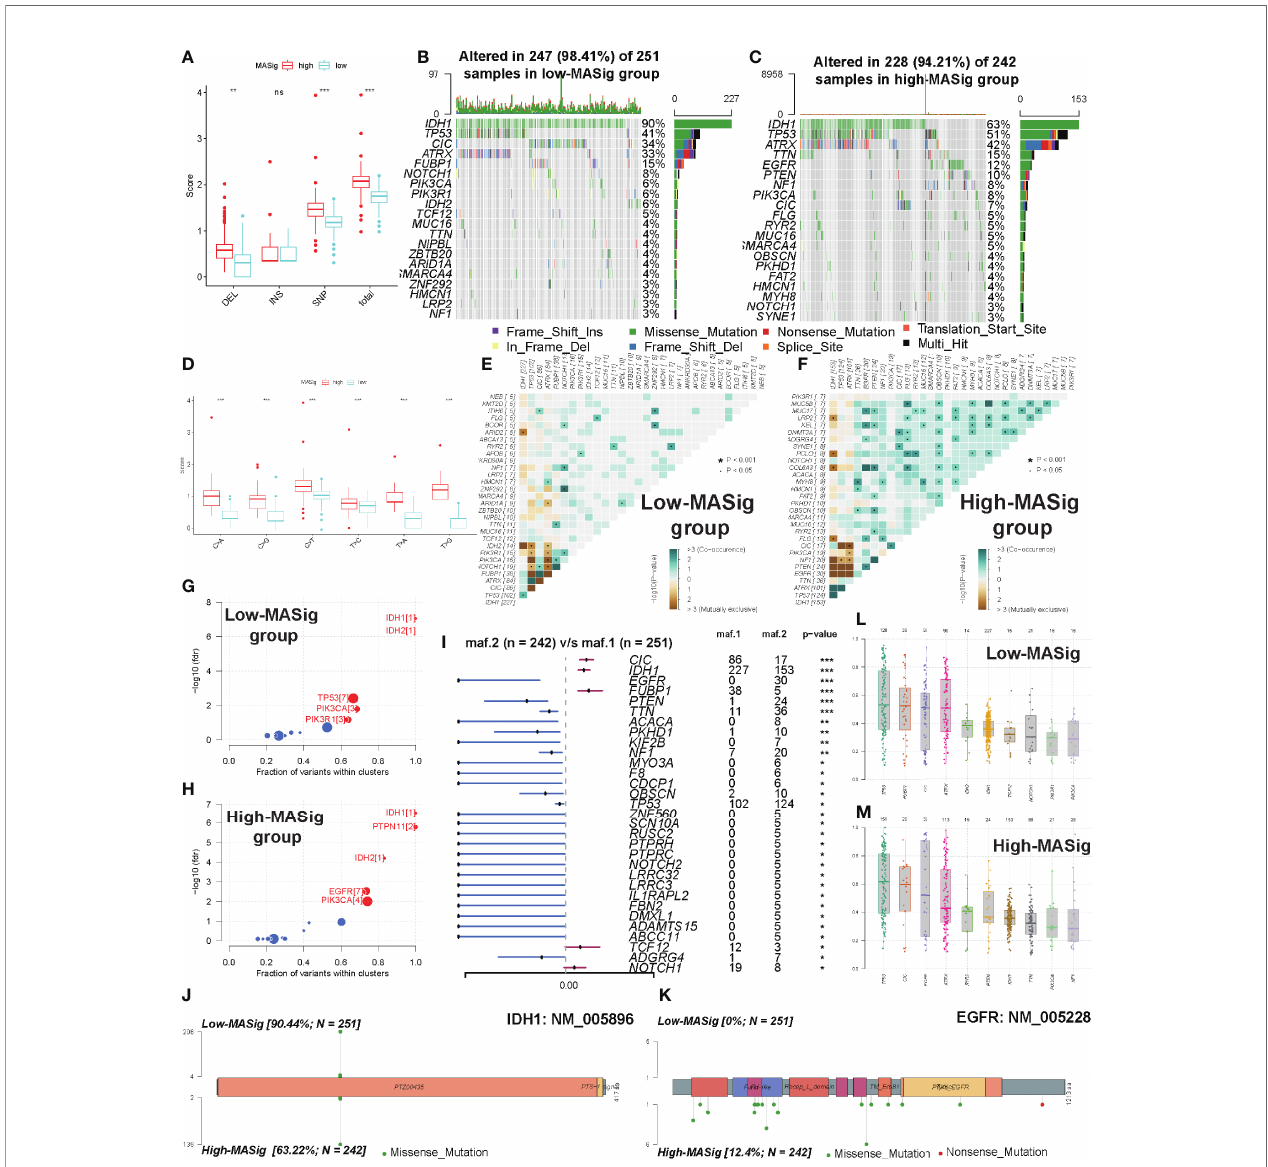
FIGURE 6 | Comparisons of somatic mutations under different MASig. (A) The differences in the fraction of deletion (DEL), insertion (INS), single-nucleotide polymorphism (SNP), and total variance between high and low MASig subgroups. (B, C) Waterfall plots about the mutation distribution of the top 20 most frequently mutated genes between low (B) and high (C) MASig subgroups. (D) Differences in the fraction of six types of single-nucleotide variants (SNV) between high and low MASig subgroups. (E, F) The correlation heatmaps about correlations of 30 top mutated genes between low (E) and high (F) MASig subgroups. The color and symbol in each square represented the statistical signi fi cance of the exclusive or co-occurrence for each pair of genes. (G, H) Driver genes of the low (G) and high (H) MASig subgroups. The horizontal line of the box plot represented the median values. (I) The forest plot about the differential mutation pro fi les of 30 most frequently mutated genes between high and low MASig subgroups. (J, K) The lollipop plots displayed the differential distribution of mutation loci and types for IDH1 (J) and EGFR (K) . In the box plots and the forest plot, p<0.05 was indicated by “ * ” , p<0.01 was indicated by “ ** ” , p<0.001 was indicated by “ *** ” , and no signi fi cant was indicated by